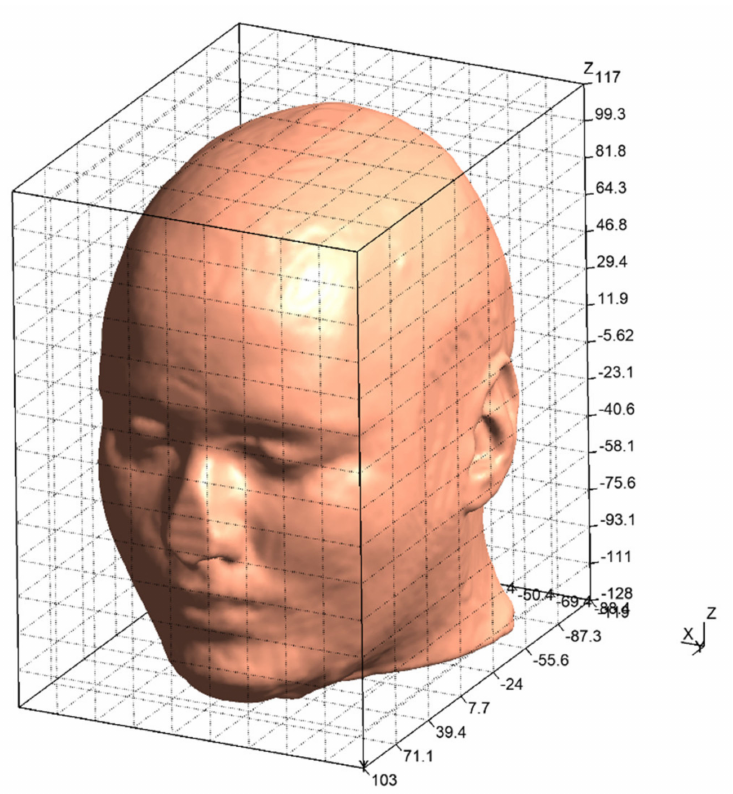
Figure 4. Full grid box of the mesh file of the human head model “Ernie”. The points on the eyeball surface set for observing the transition of the electric field value are shown in Figure 5 and Table 5. Seven points were set on the surface of the right eye, seven points on the surface of the left eye, and one point on the upper part of the nose as a point between both eyes. In this paper, the transition of the electric field on the eyeball surface is simulated, and the norm value is used as the electric field value. The norm value of the electric field is the magnitude of the electric field vector and always takes a positive value. Furthermore, the information regarding the direction of the electric field is not included in the norm value.